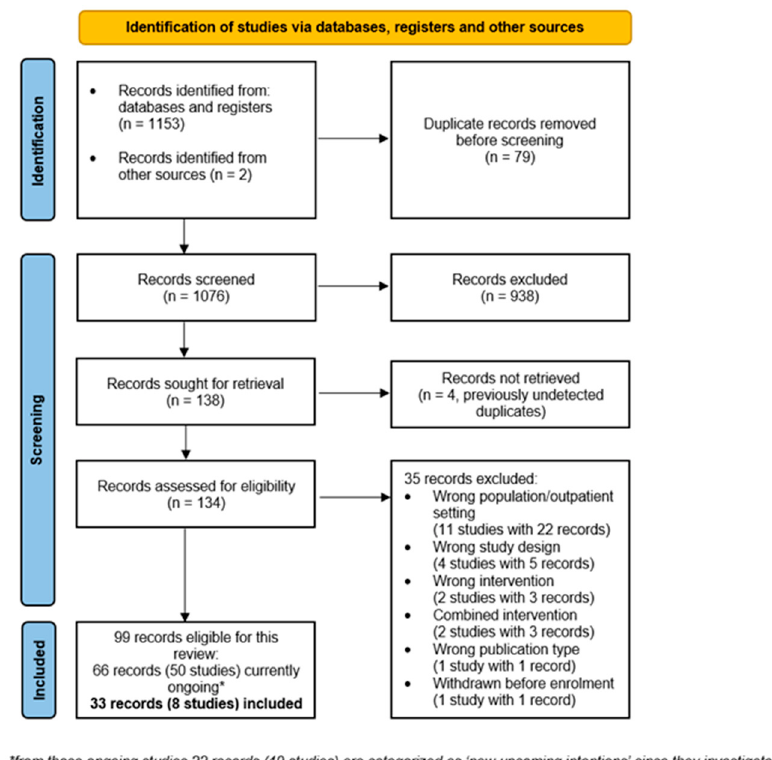
Figure 1. PRISMA flow chart [8].